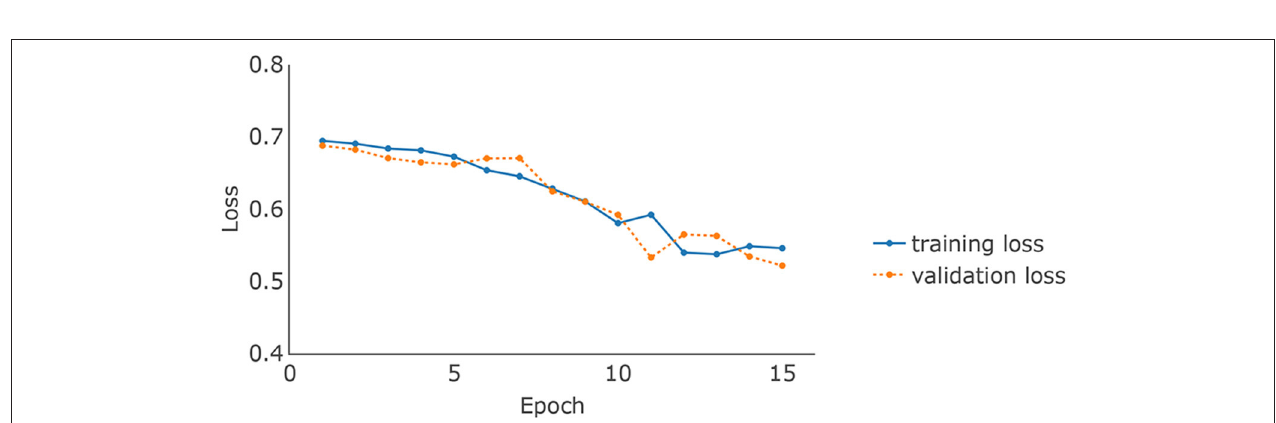
FIGURE 2 | (A) Upper panel, selected 2D slices of the input 3D brain images of 4 randomly picked AD patients; lower panel, the corresponding feature maps after 5 convolution layers (two selected filters). (B) Upper panel, selected 2D slices of the input 3D brain images of 4 randomly picked normal controls; lower panel, the corresponding feature maps after 5 convolution layers (two selected filters).